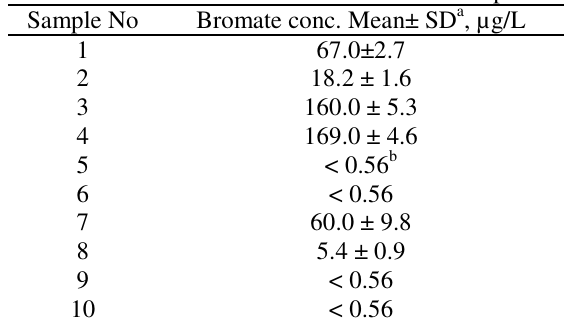
Figure 8. Chromatogram of 100 µg/L bromate ion, standard solution chromatographic conditions are listed under experimental conditions Table 7. Bromate concentration in water